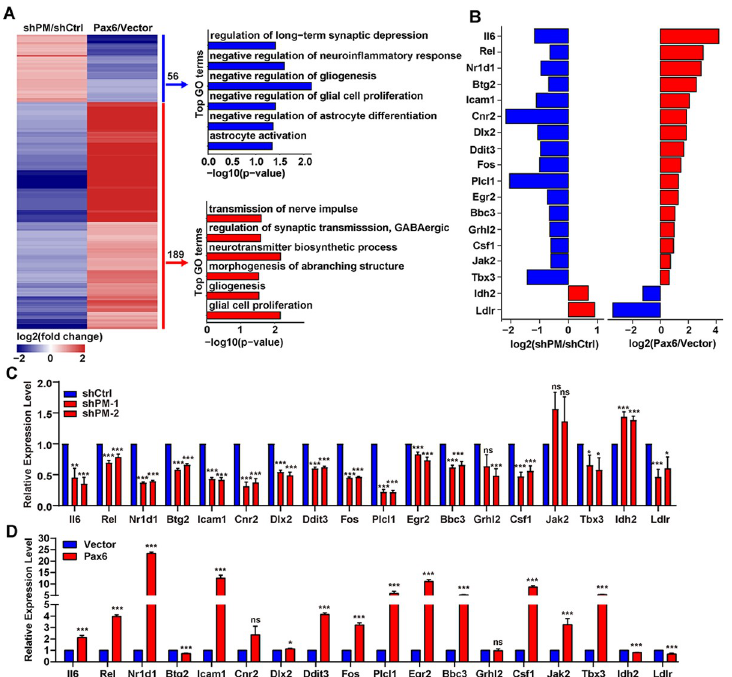
Fig 7. LncRNA-PM regulates neuronal associated genes. (A) Left: heatmap of dysregulated genes (|Fold change| > 1.5, FDR < 0.05) in PM knockdown and Pax6 overexpression RNA-seq. Right: GO biological processes of PM and Pax6 coregulated genes. Red: positively regulated genes shared by PM and Pax6 . Blue: negatively regulated genes shared by PM and Pax6 . (B) Modulations of lncRNA-PM and Pax6 impact neuronal associated genes. Expression changes for selected genes are shown as the log2 expression ratio. Red: positively regulated genes shared by PM and Pax6 . Blue: negatively regulated genes shared by PM and Pax6 . (C and D) qPCR detection of the indicated genes upon PM knockdown (C) and Pax6 overexpression (D). All the data of this figure can be found in the S1 Data file. Data are shown as means ± SEMs, n = 3. � P < 0.05, �� P < 0.01, and ��� P < 0.001. FDR, false discovery rate; GO, Gene Ontology; lncRNA-PM , lncRNA-Promoting Methylation ; ns, no significance; qPCR, quantitative PCR; RNA-seq, RNA